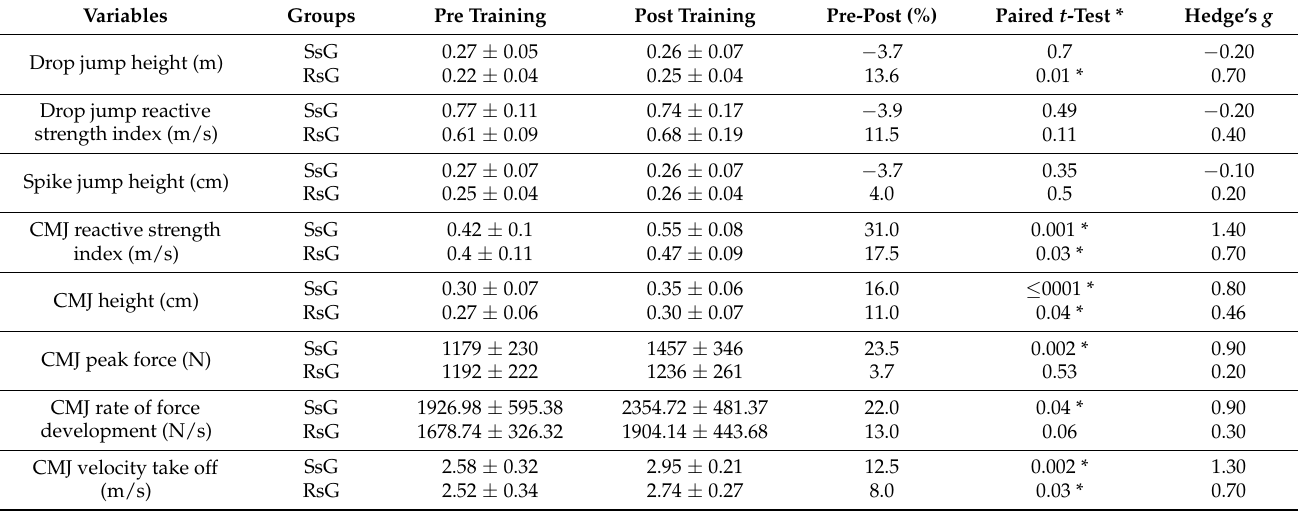
Table 3. Effects of 8 weeks of plyometric jump training conducted on sand (SsG, n = 8) compared to a rigid surface (RsG, n = 9) on vertical jump height and related biomechanical variables in female volleyball players.